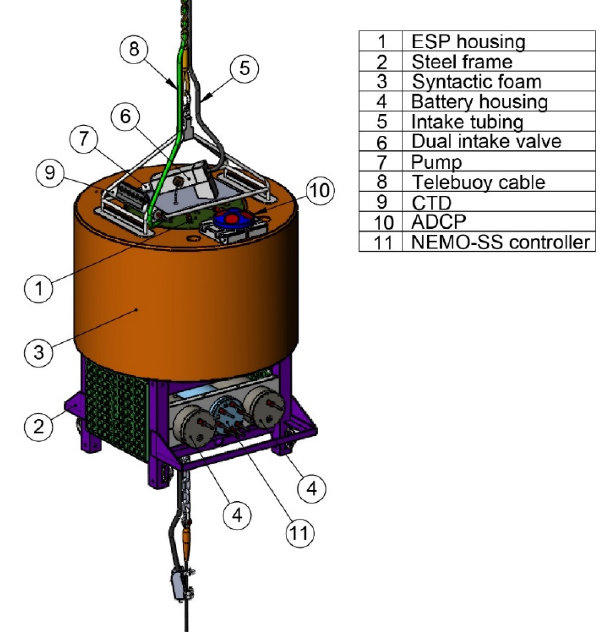
Figure 3. Engineering drawing of the NEMO-SS Environmental Sample Processor (ESP) system. The telebuoy, intake debubbler, McLane Moored Profiler, and lower mooring components are excluded from the drawing.